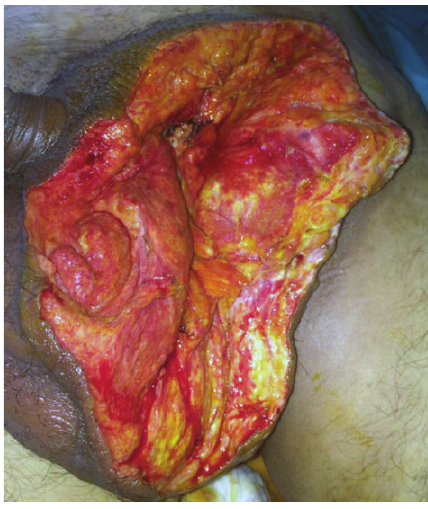
Figure 2: View of the surgical site after orchiectomy and debride- ment.